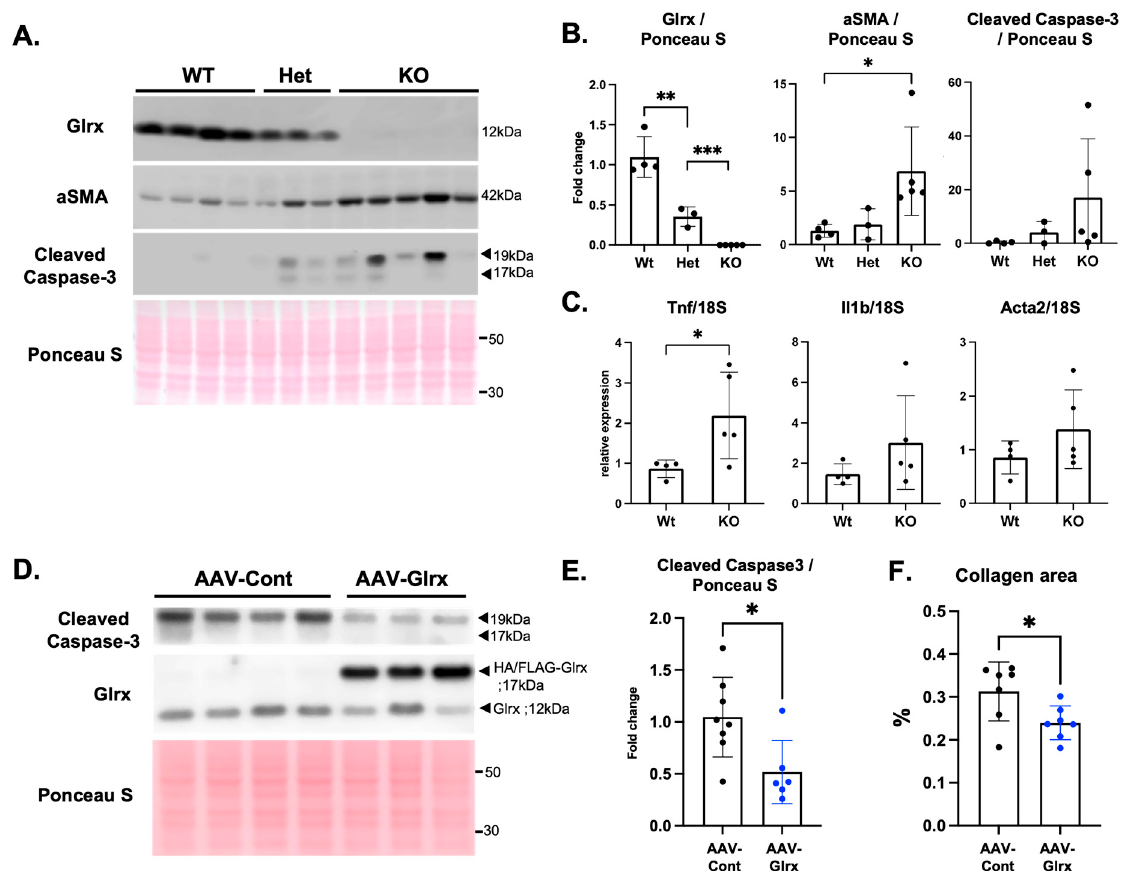
Figure 2. Glrx controls apoptosis and age-induced fibrosis in the liver. ( A ) . Protein expression of markers of fibrosis ( α SMA) and apoptosis (cleaved caspase-3) in the liver of middle-aged WT, Glrx Het (Glrx +/ − ), and Glrx KO (Glrx − / − ) mice (9–11 months old, males). ( B ). Semi-quantitative analysis of immunoblot bands normalized to Ponceau S intensities in each sample. ( C ) . Gene expression was measured by qPCR of the livers of middle-aged WT and Glrx KO mice ( n = 3–5). Tnf: tumor necrosis factor, alpha; Il1b: interleukin1 beta; Acta2: alpha-actin 2. ( D ). Cleaved caspase-3 expression in the liver of aged mice with hepatocyte-specific overexpression of Glrx. Liver samples were prepared from 22-month-old mice three months after injection of the vector. Exogenous HA/FLAG-Glrx protein expression detected in the liver after AAV-Hep-Glrx injection is shown. ( E ). Semi-quantitative analysis of cleaved caspase-3 expression. ( F ). Collagen-stained area (%) in the liver after AAV-Hep-control or AAV-Hep-Glrx injection ( n = 7, males and females, 22 months old). Blue dots on the graph indicate mice treated with AAV-Hep-Glrx. * p < 0.05, ** p < 0.01. *** p < 0.001. Error bars indicate standard error.